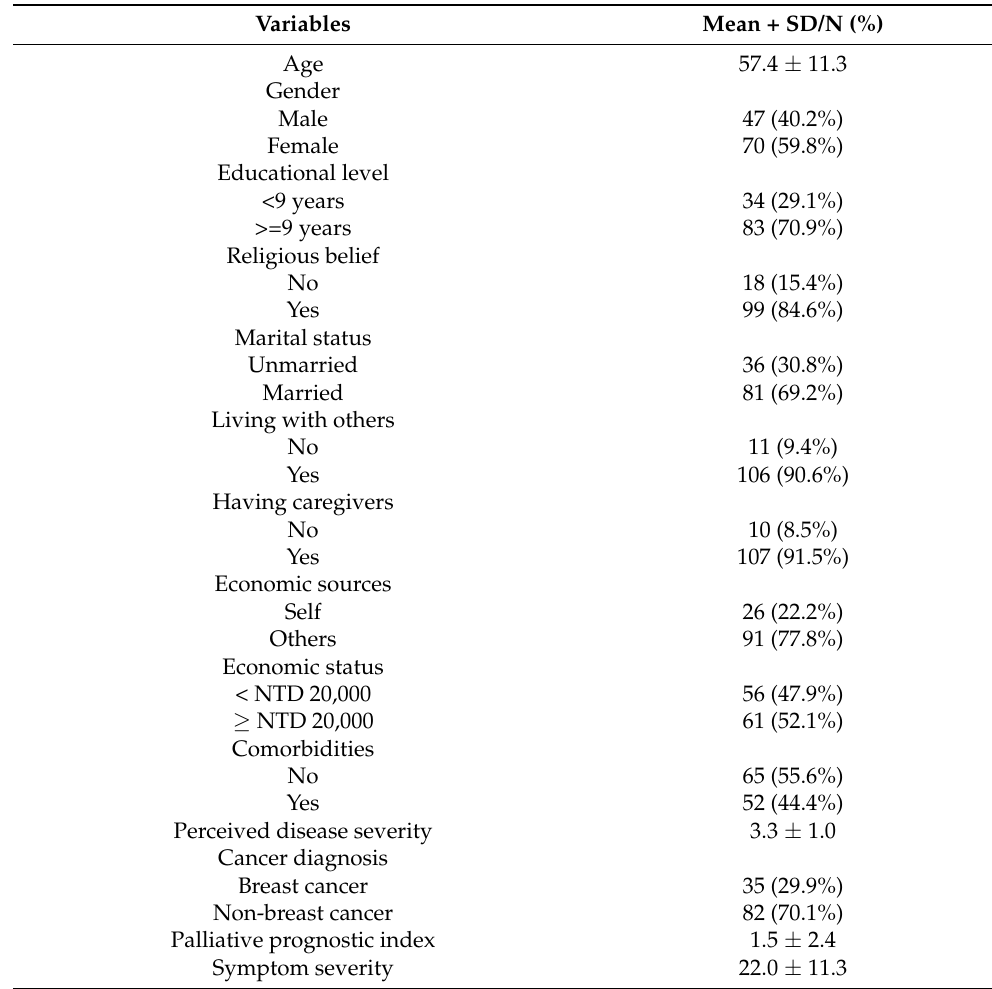
Table 1. Characteristics of terminally ill cancer patients (N = 117).